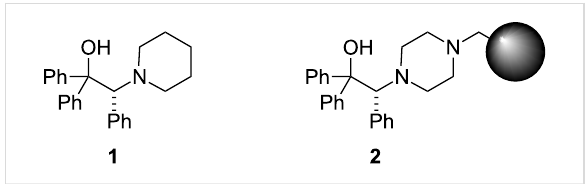
Figure 2: Structures of ( R )-1,1,2-triphenyl-2-(piperidin-1-yl)ethanol ( 1 ) and its polystyrene-immobilized analogue 2